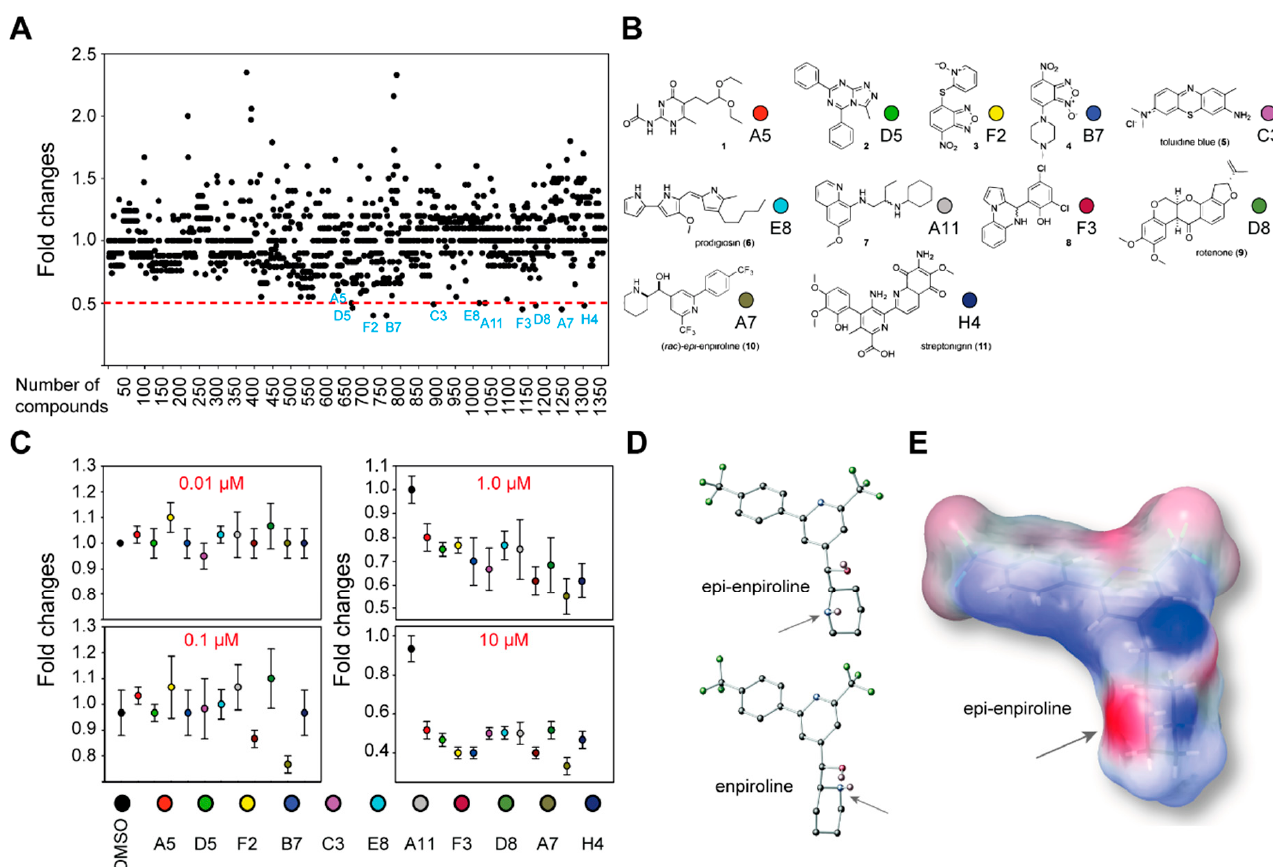
Figure 1. Identification of epi -enprioline as a selective inhibitor of neuroblastoma Be2c cells. ( A ) Be2c-VCR cells (VCR-20) were treated with small molecules or DMSO for 48 h. Cell viability was measured using the MTT assay and calculated as fold changes compared to DMSO-treated cells ( n = two independent experiments in triplicate). ( B ) The chemical structure of molecules that could reduce the survival of resistant cells by at least 50%. ( C ) VCR-20cells were treated with di ff erent concentrations of molecules identified in Figure 1A. Cell viability was measured using MTT assay and calculated as fold changes compared to DMSO-treated cells ( n = two independent experiments in triplicate, mean ± SEM). ( D ) Chemical structures of epi -enpiroline and enpiroline. Arrows highlight the piperidine nitrogen atom in each structure. ( E ) Electrostatic potential surface map of epi-enpiroline in a low-energy conformation. Treatment of vincristine-resistant NB cells with epi -enprioline reduces both proliferation and number of surviving cells (Figure 2A,B), as well as the number of colonies (Figure 2C). The sensitivity of other vincristine-resistant NB cells to epi -enprioline was confirmed using SK-N-AS-VCR-20 (IC 50 = 1.2 + 0.7 µM) and UKF-NB-4-VCR-50 (IC 50 = 3.05 + 0.7 µM). Treatment of these chemoresistant NB cells with epi -enprioline reduced proliferation and cell survival (Figure 2D–G). Furthermore, LU-NB- 2 PDX cells, derived from a NB brain metastasis following treatment relapse were highly sensitive for epi -enprioline with an IC 50 value of 0.5 µM (Figure 2H). Treatment with epi -enprioline caused markedly decreased LU-NB-2 PDX cell viability (Figure 2I). In addition, epi -enprioline was not affecting the survival of primary embryonic fibroblasts (Figure S2).